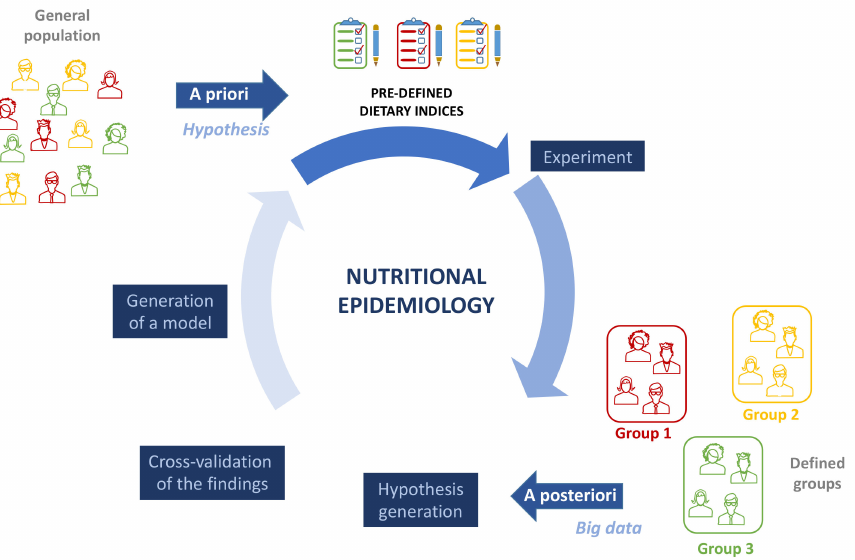
Figure 2. Two main approaches may be used to study the role of dietary patterns as a modifiable lifestyle factor in autoimmune diseases. The a priori or hypothesis-driven approach examines the adherence to pre-defined dietary indices in relation to AD development or disease relapse. On the contrary, a posteriori or data-driven approaches use statistical tools—dimension reduction methods or clustering—to investigate the relationships between ADs and diet. Given that a posteriori approach evaluates big data, analysis may generate a new hypothesis, which, once validated, may establish new models for a priori